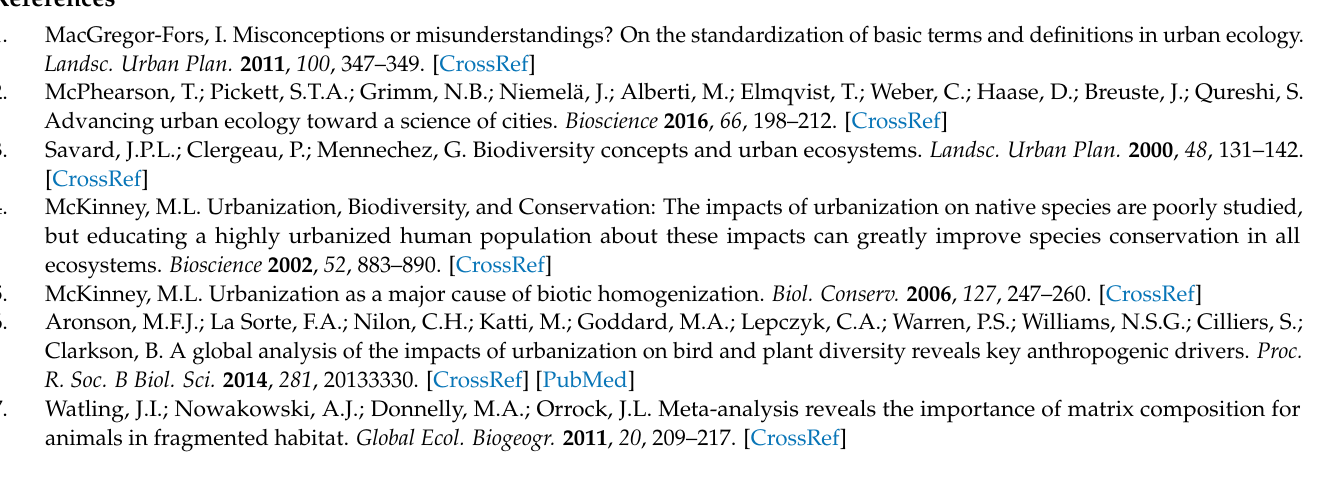
able selection; Table S1: Cat and dog detections; Table S2: Summary statistics for coefficients of parameters in the residential rat model; Table S3: Rat detection odds compared (a) between cities, averaging over habitat types, and (b) between cities within each habitat type; Table S4: Rat detection odds compared (a) between habitat types, averaging over cities, and (b) between habitat types within each city; Table S5: Summary statistics for coefficients of parameters in the residential hedgehog model; Table S6: Hedgehog detection odds compared (a) between cities, averaging over habitat types, and (b) between habitat types, averaging over city; Table S7: Summary statistics for coefficients of parameters in the residential mouse model; Table S8: Mouse detection odds compared (a) between cities, averaging over habitat types, and (b) between cities within each habitat type; Table S9: Mouse detection odds compared (a) between habitat types, averaging over cities, and (b) between habitat types within each city; Table S10: Possum detection odds compared (a) between cities, averaging over habitat types, and (b) between cities within each habitat type; Table S11: Possum detection compared (a) between habitat types, averaging over cities, and (b) between habitat types within each city; Table S12: Two city model: Rat detection compared (a) between habitat types, averaging over cities, and (b) between habitat types within each city; Table S13: Two city model: Hedgehog detection compared between habitat types; Table S14: Two city model: Mouse detection compared (a) between habitat types, averaging over cities, and (b) between habitat types within each city; Table S15: Two city model: Possum detection compared (a) between habitat types, averaging over cities, and (b) between habitat types within each